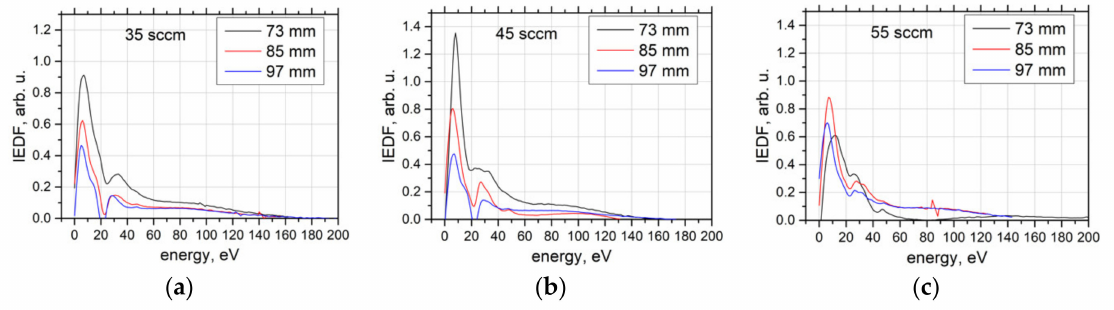
Figure 14. Ion energy distribution functions. ( a )—35 sccm; ( b )—45 sccm; ( c )—55 sccm.